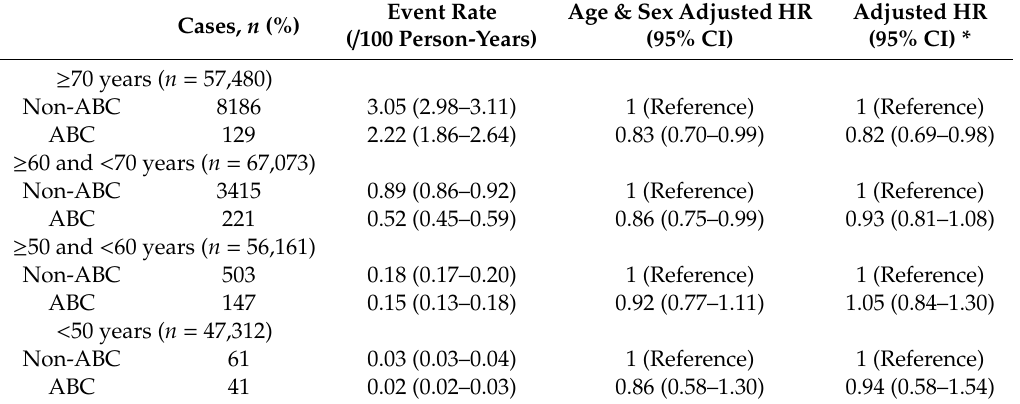
Table 4. Risk of dementia for the non-ABC vs. ABC groups in di ff erent age subgroups. Cases, n